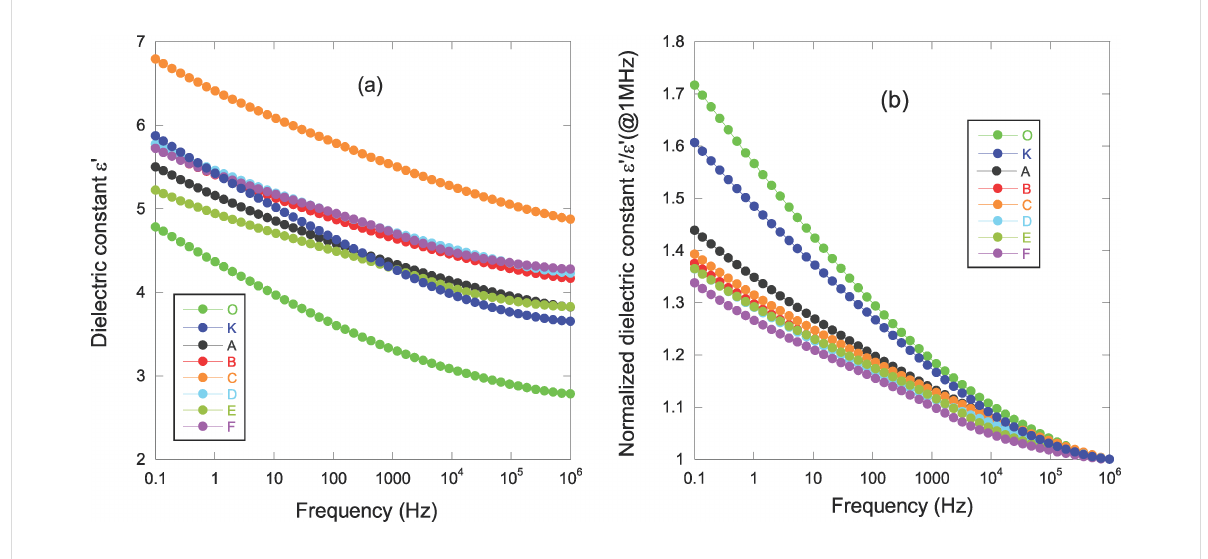
Figure 6: a) Dielectric constant ε ’ as a function of the frequency; b) normalized dielectric constant ε ’/ ε ’ HF (@1 MHz).